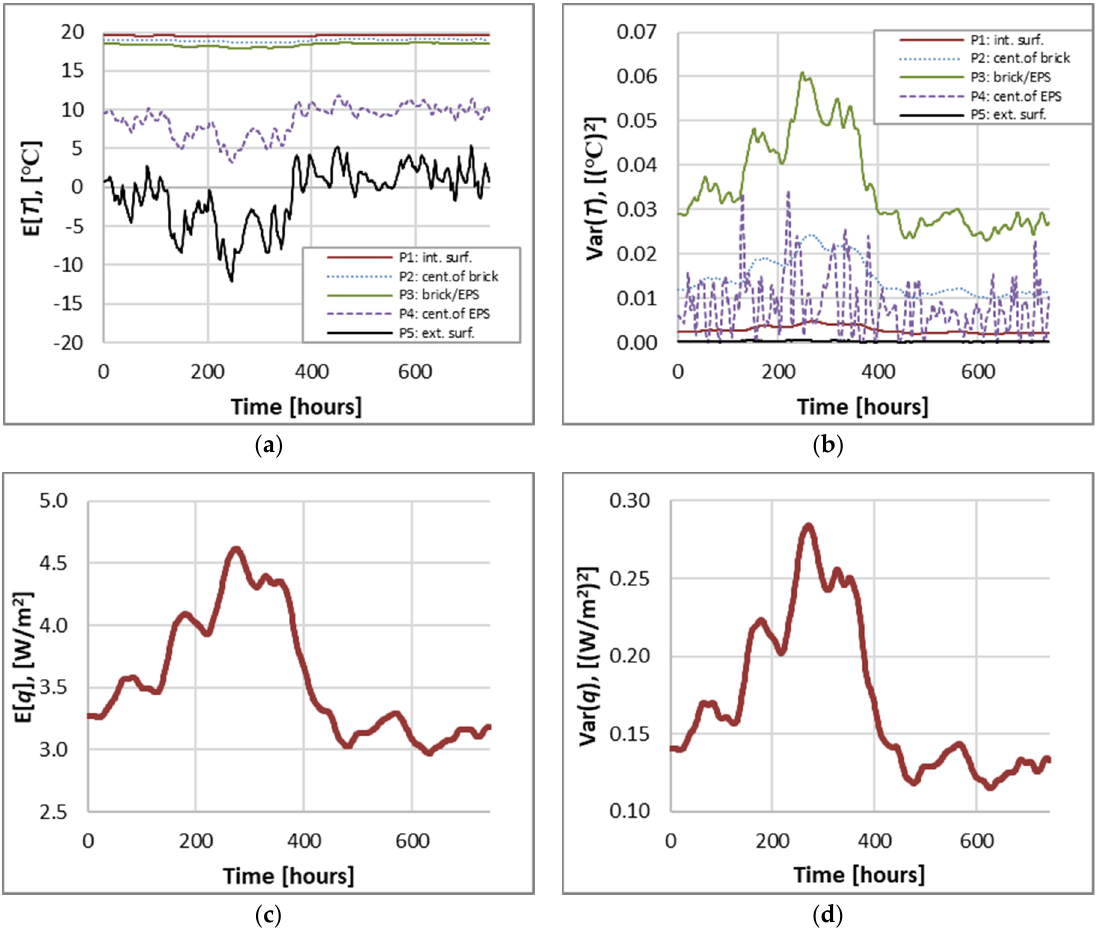
Figure 5. ( a ) Expected value and ( b ) variance of temperature in 5 points in the wall and ( c ) expected value and ( d ) variance of heat flux on the internal side of the wall in January obtained using the perturbation method for Case 1.